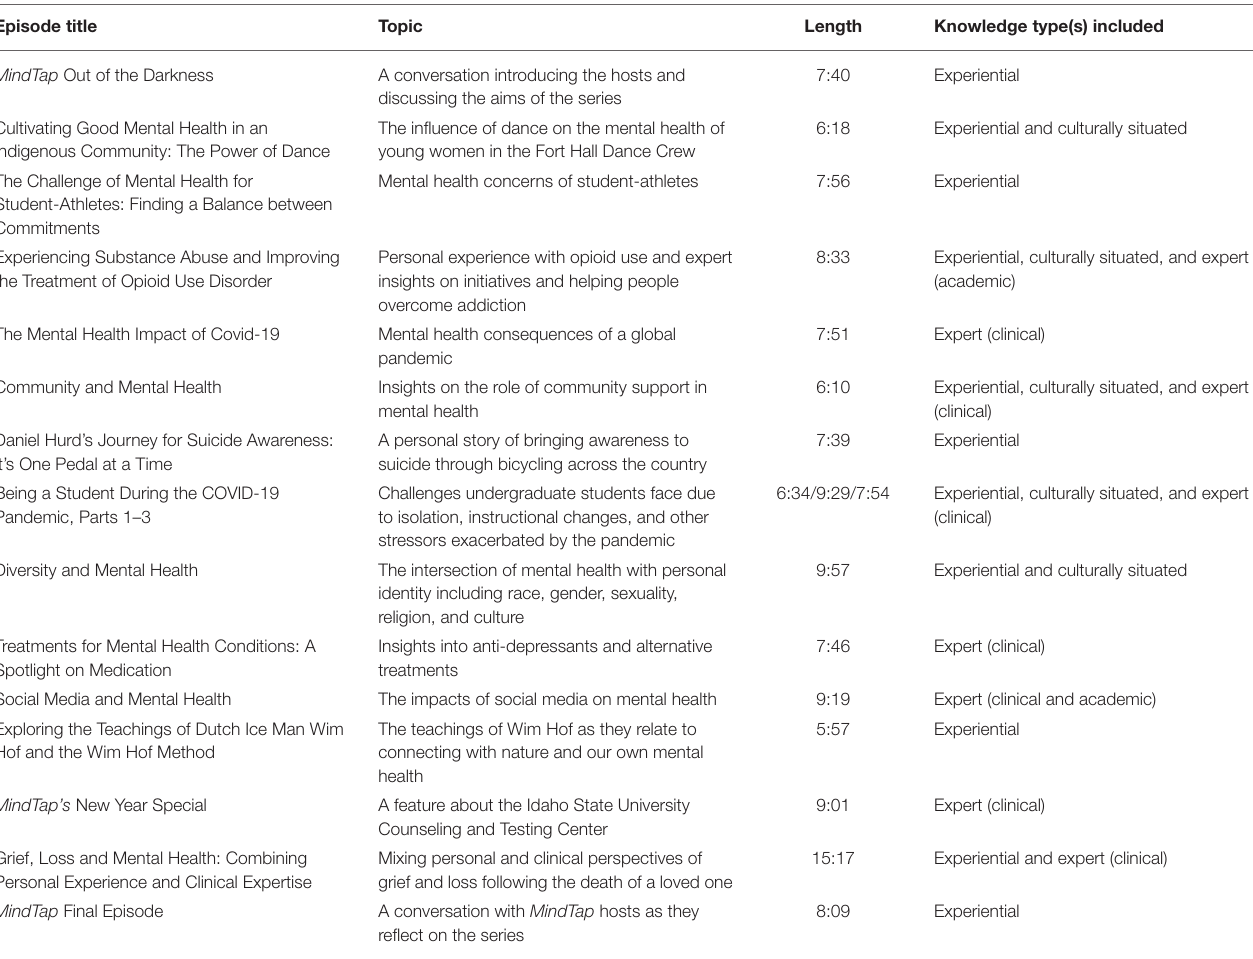
TABLE 1 | MindTap episode titles, topics, lengths, and knowledge types included. Episode title Topic Length Knowledge type(s) included MindTap Out of the